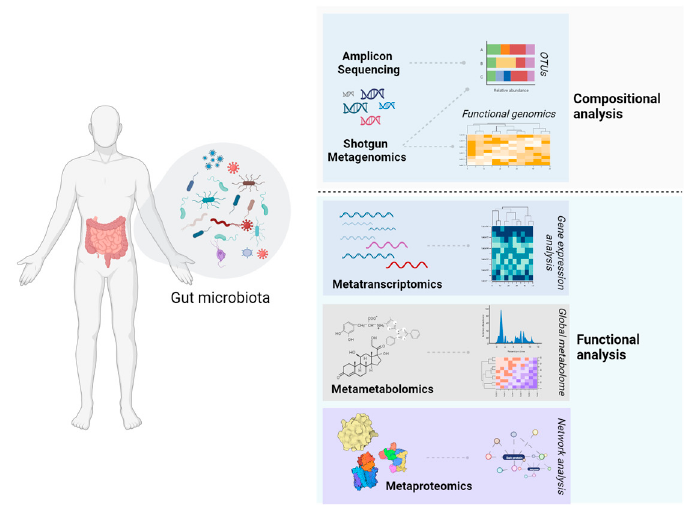
Figure 1. Omic platforms for the characterization of gut microbiota. Amplicon sequencing or metataxonomics detect only part of the gut microbiota, whereas shotgun metagenomics targets all organisms (bacteria, viruses, fungi, and protozoa) present in the community. The study of the transcripts (metatranscriptomics), metabolites (metametabolomics), or proteins (metaproteomics) facilitates the construction of microbe–microbe and microbe–host interaction networks. Created with BioRender.com.